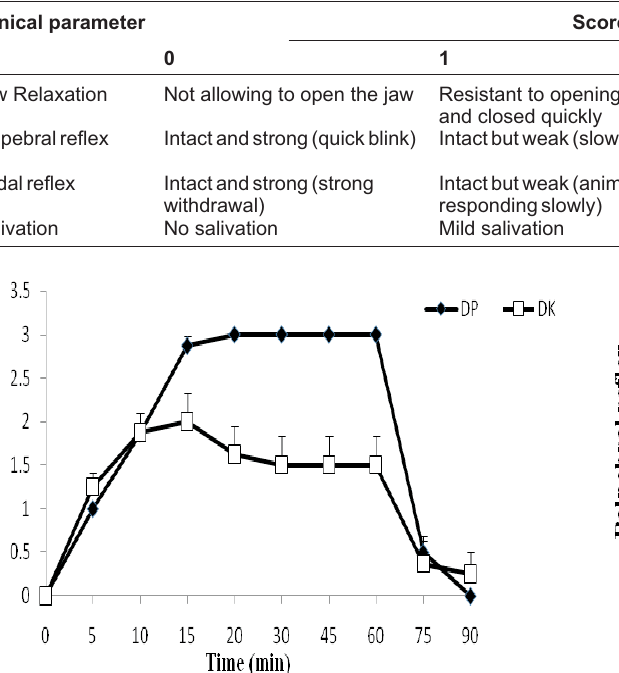
Figure-1: Mean±SE score for jaw relaxation in the animals of groups DP and DK at different time intervals.